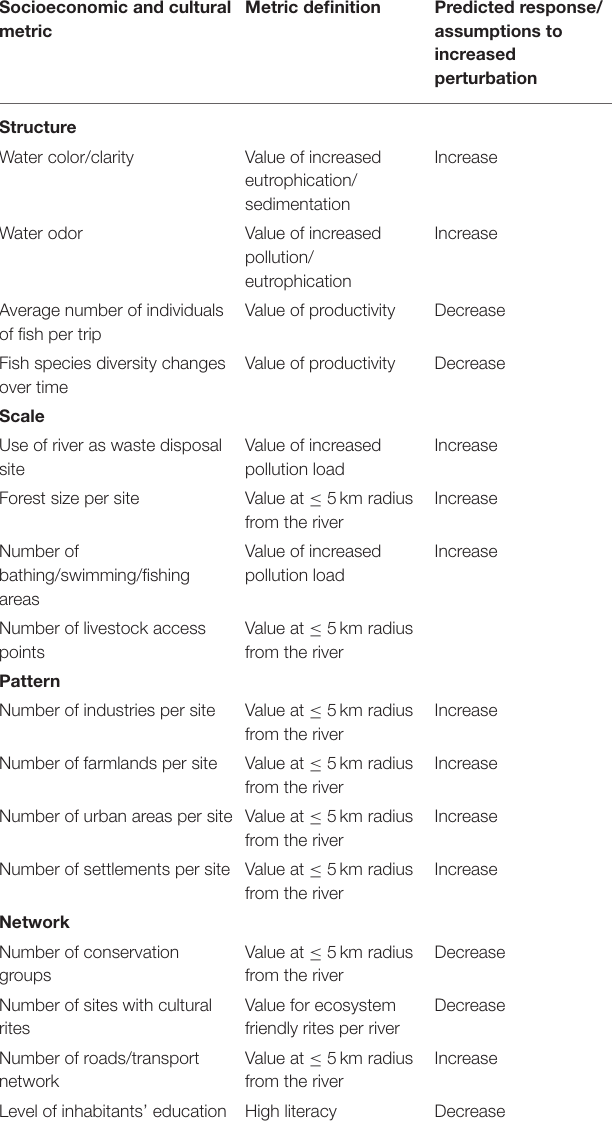
TABLE 1 | Socioeconomic and cultural metrics and definitions that were evaluated for the development of the Citizen Index of Ecological Integrity (CIEI) for major rivers in the lower reaches of Lake Victoria Basin, Kenya and their predictive responses to increased levels of